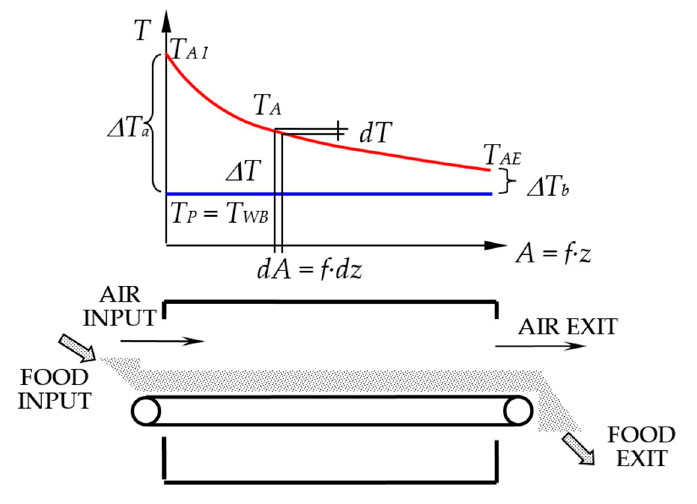
Figure 2. The conveyor-belt dryer with tangential flow and diagram of the temperature of the air and product with a final moisture content X F > X C .